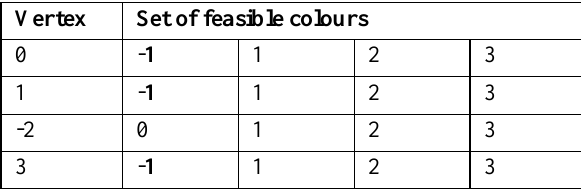
Table 4: Updated colour matrix after allocation of colour 0 to vertex 2.